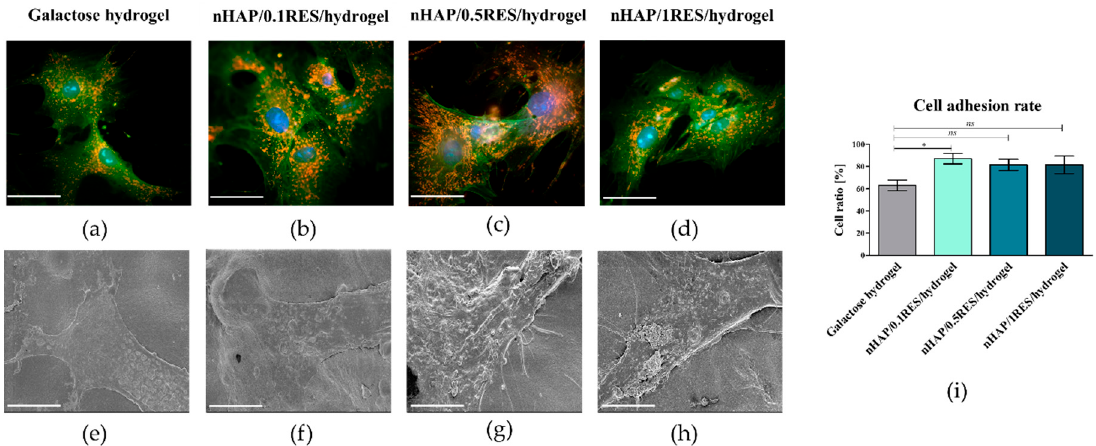
Figure 8. The images obtained using epifluorescence microscope ( a – d ) and SEM ( e – h ). The cultures of hASCs were cultured on galactose hydrogel ( a , e ), and biomaterials functionalized with 0.1 resveratrol ( b , f ), 0.5 resveratrol/nHAp/hydrogel ( c , g ), and 1.0 resveratrol/nHAp/hydrogel ( d , h ). The results of adhesion rate noted for hASCs cultured on tested scaffolds (i). Comparative analysis of adhesion rates revealed that nHAp/hydrogel functionalized with 0.1 mM of resveratrol significantly (* p < 0.05) improves the adhesion of hASCs. Non-significant ( ns ) increase of adhesion rate was noted in cultures on nHAp/hydrogel with 0.5 and 1 mM of resveratrol. The EpiFM observations were carried out under 60-fold magnification. The scale bar is 40 μ m. The following structures of cells were visualized: actin cytoskeleton (phalloidin—green), nucleus (DAPI—blue), mitochondria (MitoRed—orange). The SEM images were captured under 2500-fold magnification; scale bar is 4 μ m.